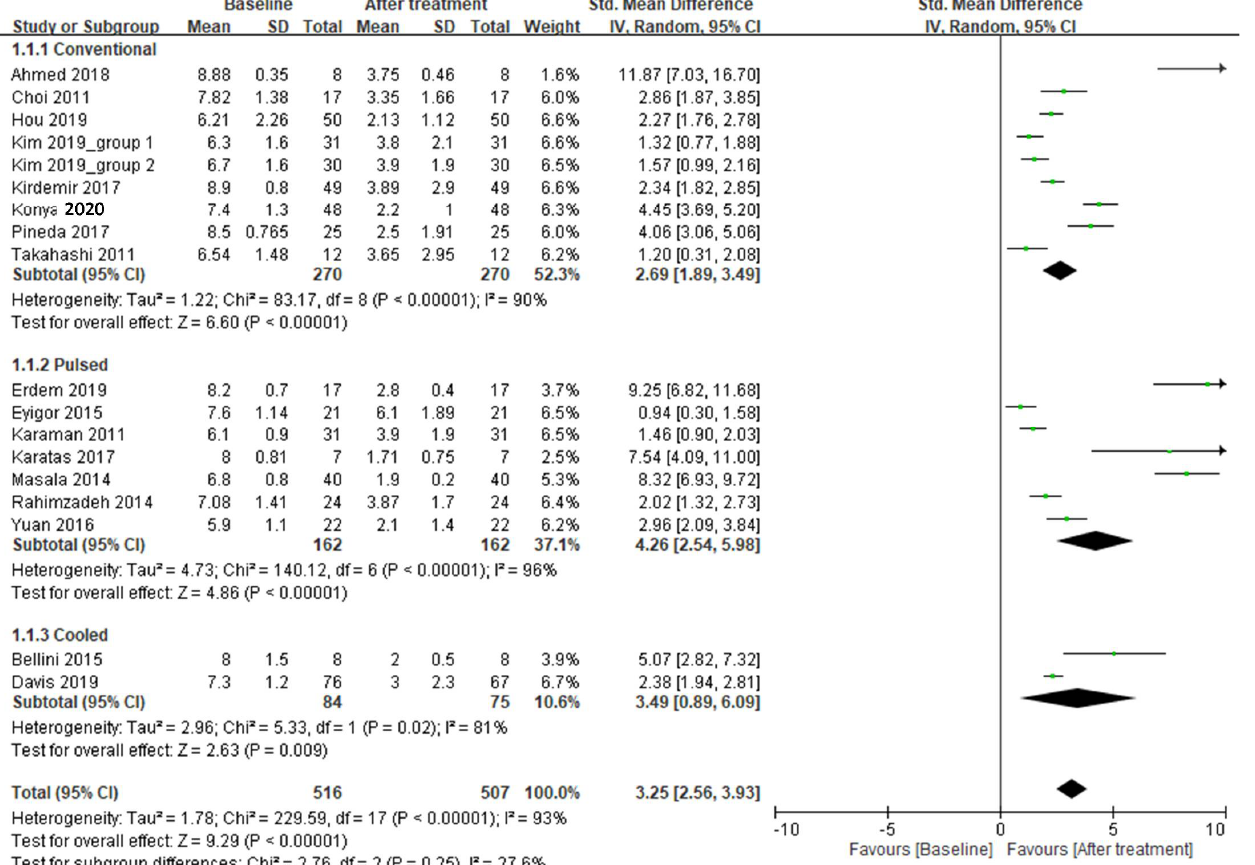
Figure 2. Meta-analysis of efficacy in pain using three radiofrequency ablation techniques to treat knee OA at the 1-month follow-up.